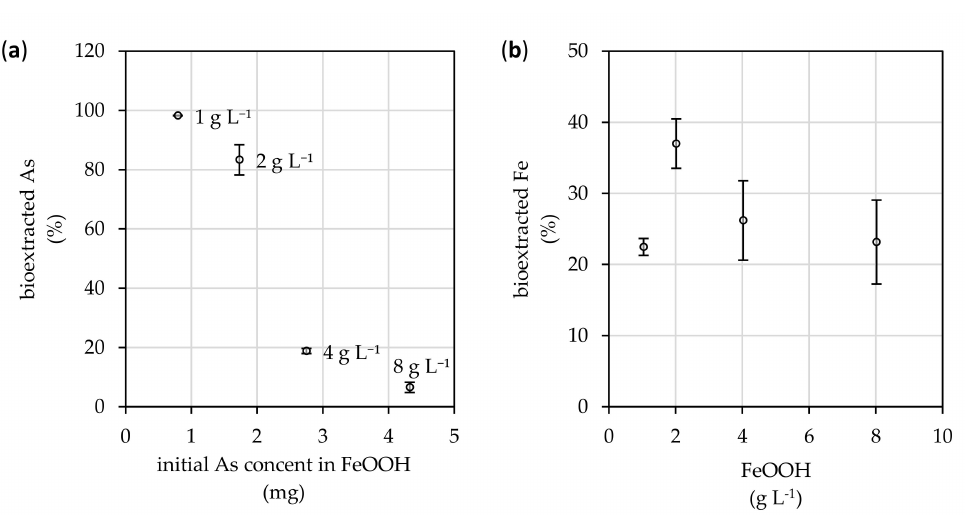
Figure 3. The e ffi ciency of ( a ) arsenic and ( b ) iron bioextraction from the arsenic-treated FeOOH adsorbent after a 19-day exposure period to the fungal Aspergillus niger strain during its static cultivation at 25 ◦ C. Results represent the mean values of four independent experiments, and the error bars show the standard